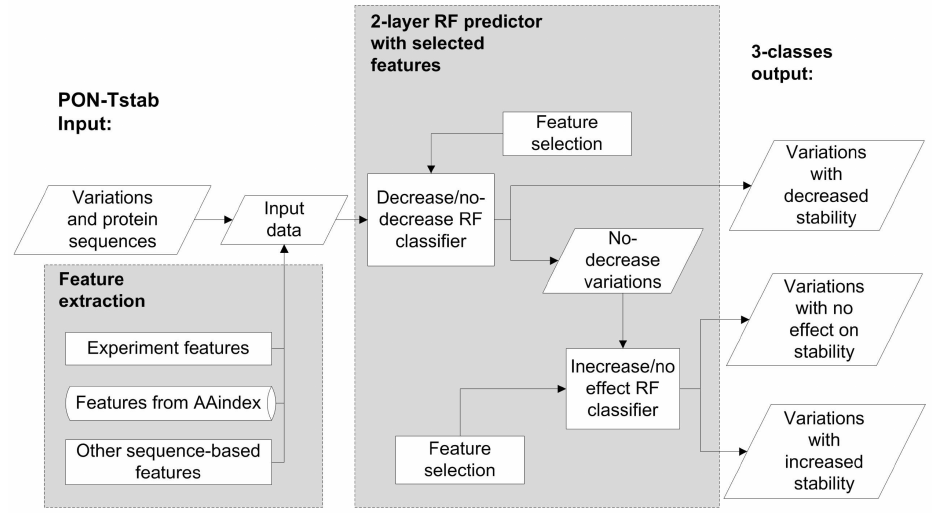
Figure 3. The scheme for the PON-tstab predictor. A two-layer random forest predictor was developed to predict increasing, decreasing or having no change on variant stability. RF, random